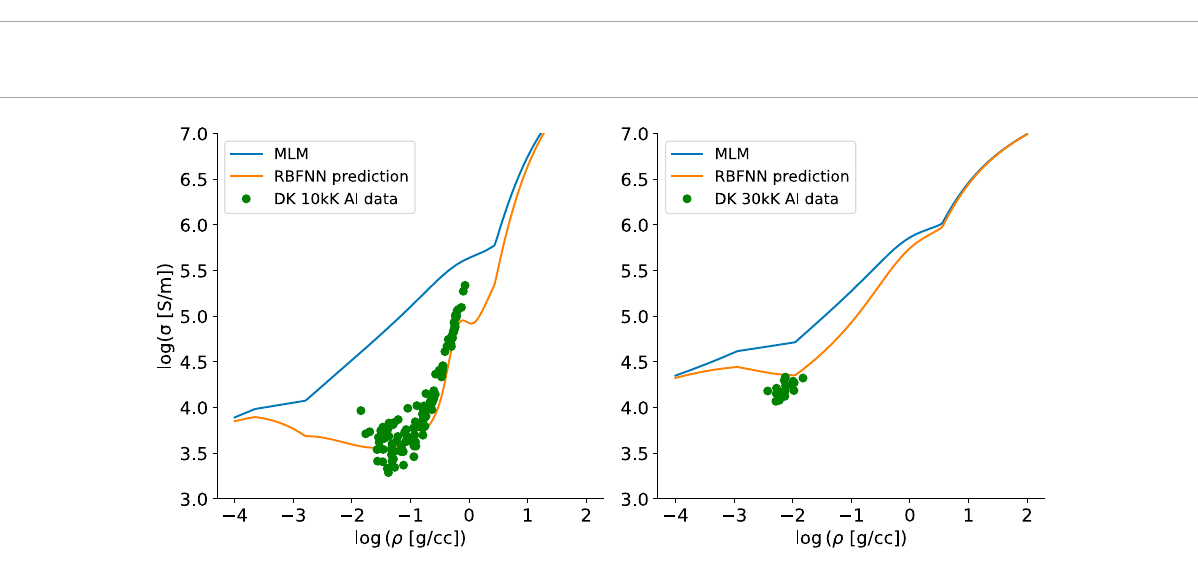
FIGURE 10 DK training data for Al are shown as green dots, with the base MLM model shown as the top, blue curve. The RBFNN model is shown in orange, whichpredictsthedatawellandasymptotically(awayfromthedata)tendstothetrend T ,whichistheMLMmodel.Here, fi vecenterswereused,and the covariance scale hyperparameter was learned from the data in the panel on the left; thus, the prediction in the right panel serves as a test. The magenta triangles indicate the test data (random 20% of the total